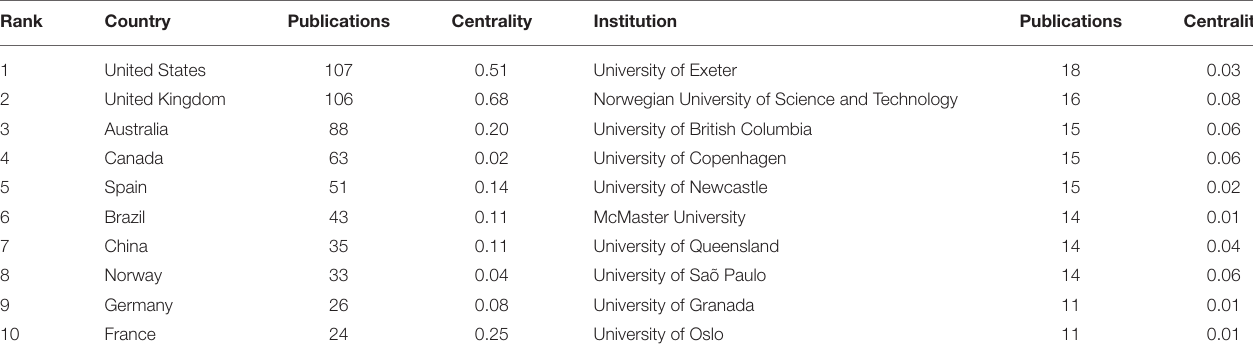
TABLE 1 | Ranking of top 10 countries and institutions involved in the HIIT-HP